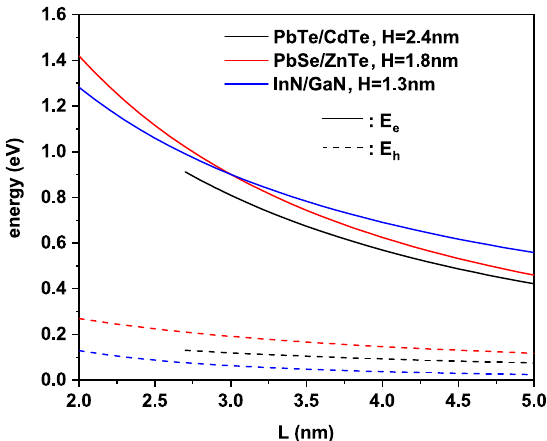
Figure 2. Fundamental electron (solid lines) and heavy hole states (dashed lines) versus dot size L for different materials at the optimum inter-dot spacing H = 2.4 nm, 1.8 nm and 1.3 nm for PbTe/CdTe, PbSe/ZnTe and InN/GaN QD